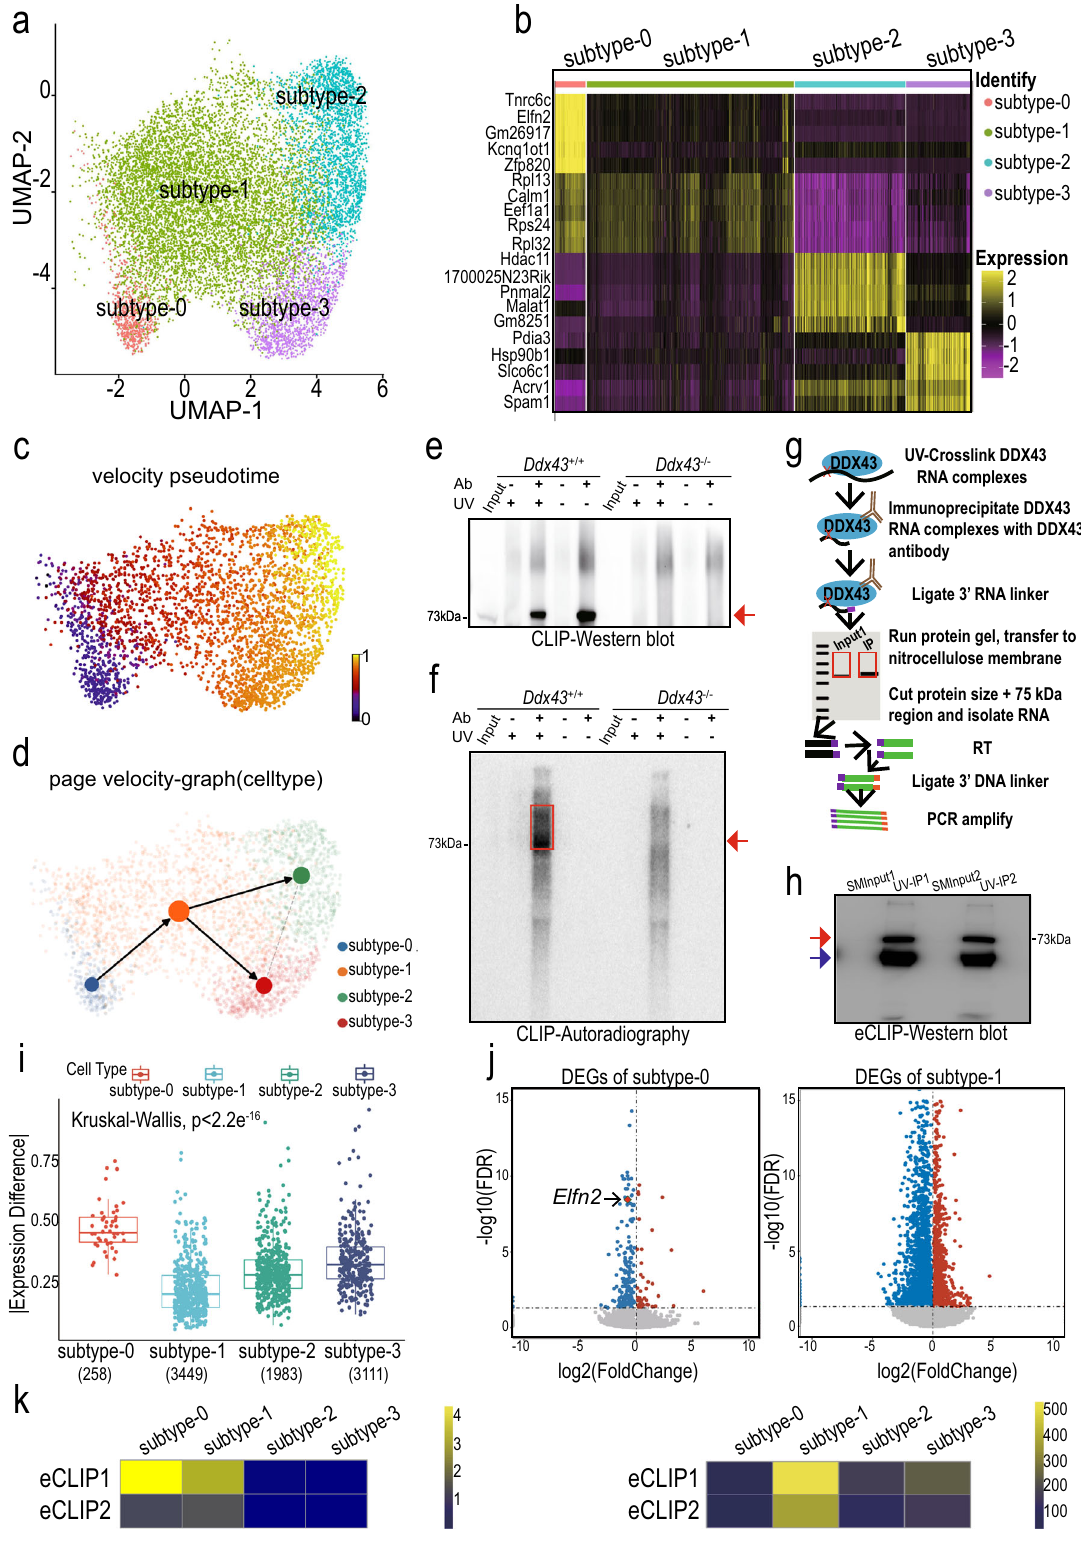
con fi rmed the existing of Elfn2 transcript in subtype-0 STids (Fig. 6h). Gene spliced-unspliced life cycle analysis also showed that Elfn2 tends tohave higherratioof unspliced transcriptsin Ddx43 KI/KI testis (Fig.6i, j and Supplementary Fig. 15c, d). Our integrated data analyses suggest that the downregulation of the hub gene Elfn2 may lead to the imbalance of the ‘ brown module ’